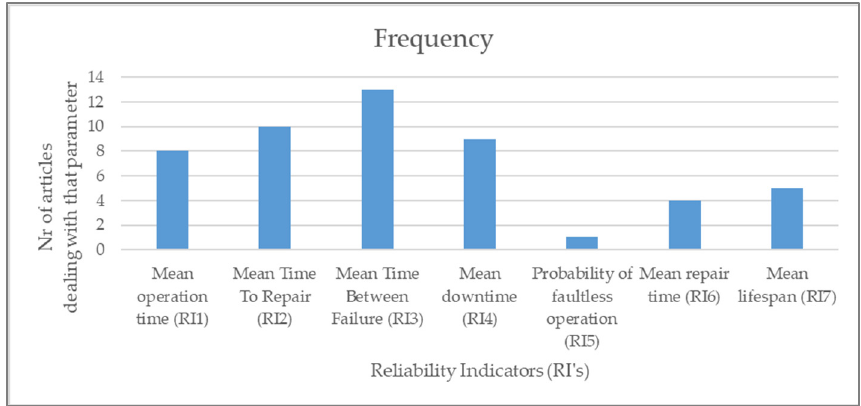
Figure 3. Frequency table.